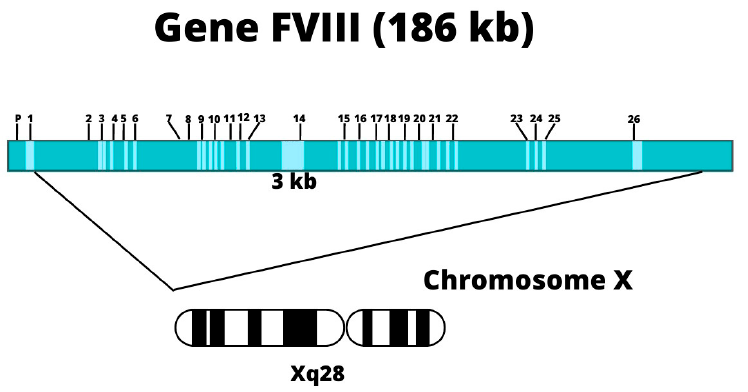
Figure 3. The gene covers 186 Kb of genomic DNA, consists of 26 exons, and encodes a 9.0 Kb [21] messenger RNA (mRNA), encoding a precursor polypeptide of 2351 amino acids, synthesised mainly by liver cells (hepatocytes) [10,14,22].